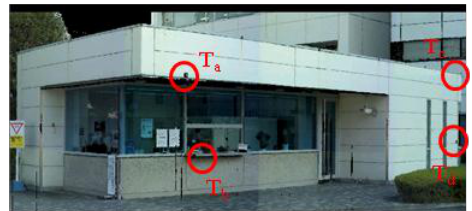
Figure 13. Location of the four signalized targets used to verify the accuracy of the proposed